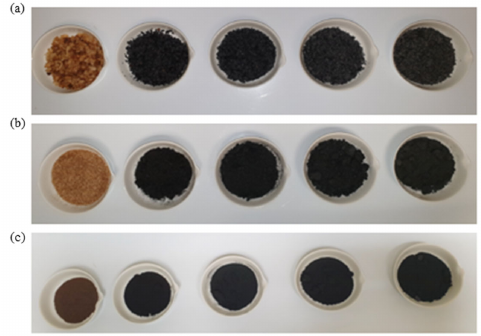
Figure 5. Original CSS ( a ), ground CSS ( b ), and SC ( c ), and the solid fractions obtained by pyrolysis at 300, 400, 500, and 600 °C.